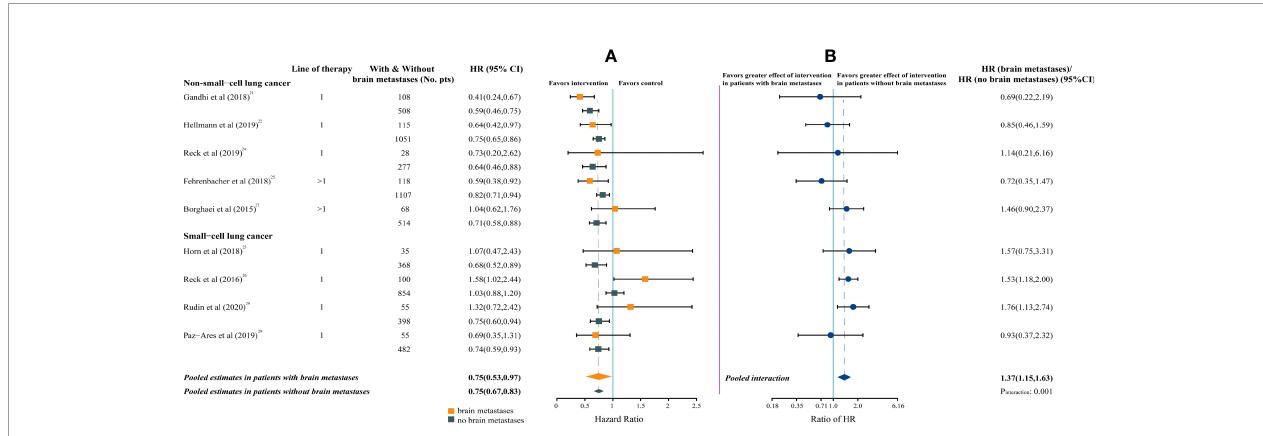
FIGURE 2 | Forest Plot of Hazard Ratios for Death According to Brain Metastases. (A) , Hazard Ratios (HRs) of death for patients assigned to intervention group, compared with those assigned to control group, by brain metastases. (B) , The interaction between immunotherapy ef fi cacy and brain